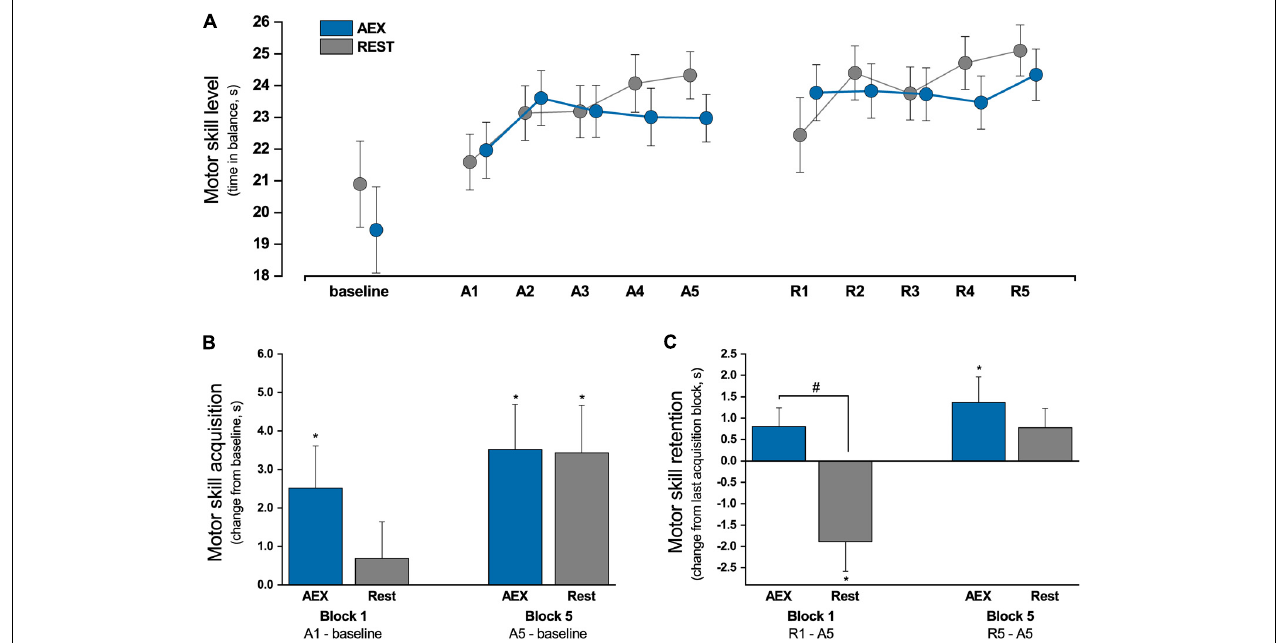
FIGURE 2 | Motor skill performance. (A) Motor skill performance (time in balance) during acquisition (A1–A5) and retention (R1–R5); (B) online skill gains illustrated as change from baseline block to first (A1) and last (A5) acquisition block, ∗ significantly different from baseline (paired t -test p ≤ 0.036); (C) motor skill retention illustrated as change from last acquisition block (A5) to first (R1) and last (R5) retention block, ∗ significantly different from baseline (paired t -test p ≤ 0.036), # significant difference between aerobic exercise (AEX) and REST condition ( F 1 , 32 = 10.734, p = 0.003); error bars indicate 1